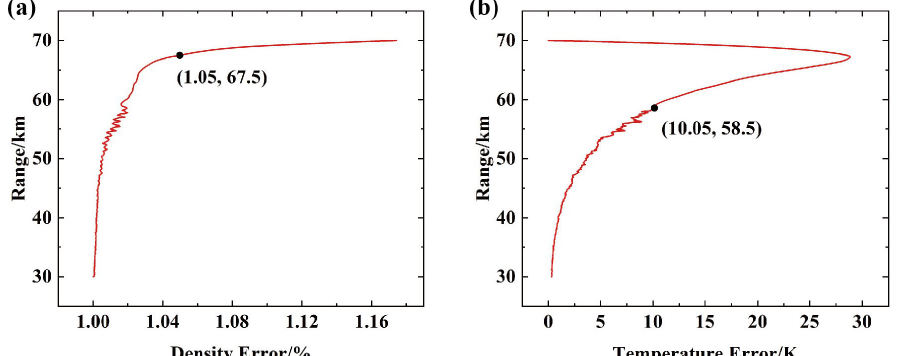
Figure 8. The absolute error of ( a ) density and ( b ) temperature retrievals with the WT-EEMD-LOWESS